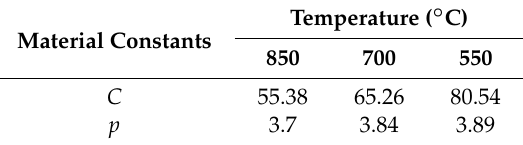
Table 4. Material constants of boron steel in the Cowper–Symonds model.